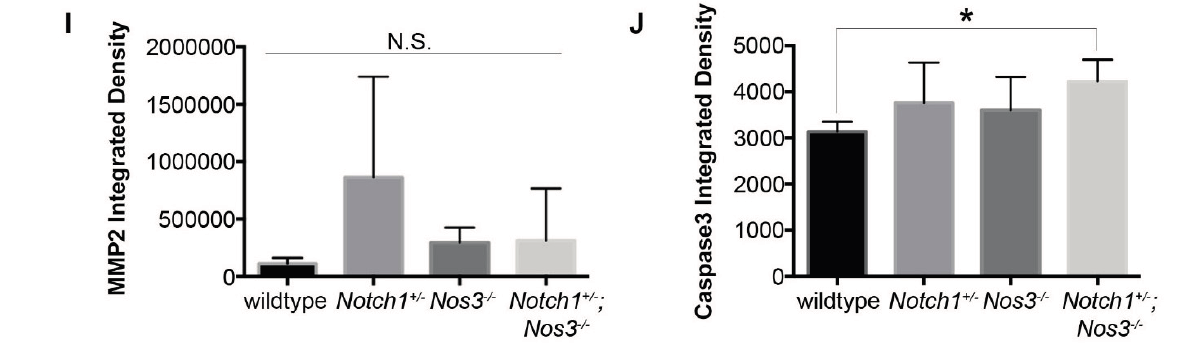
Figure 5. Immunohistochemical evidence of aortopathy in Notch1 +/ − ; Nos3 − / − mice. MMP2 protein expression is increased in Notch1 +/ − ; Nos3 − / − , Nos3 − / − , and Notch1 +/ − in comparison to wildtype ( A – D , I ). Caspase-3 protein expression is increased in Notch1 +/ − ; Nos3 − / −